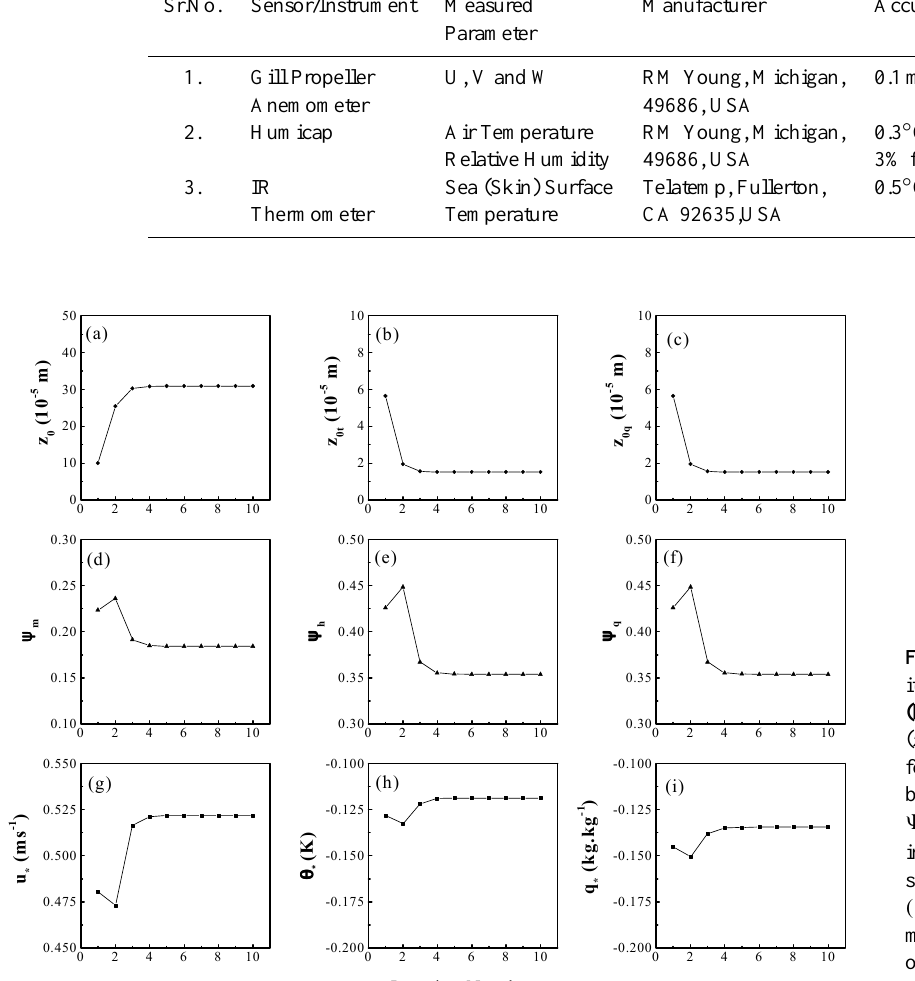
Table 1. Accuracy of measurement of a few sensors Sr.No. Sensor/Instrument Measured Manufacturer Accuracy Parameter